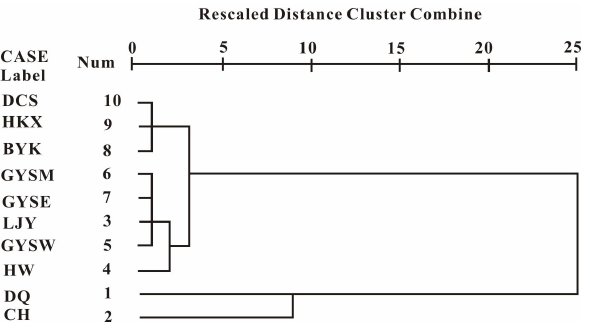
Fig. 4. Dendrogram showing sampling site clusters on Dianchi